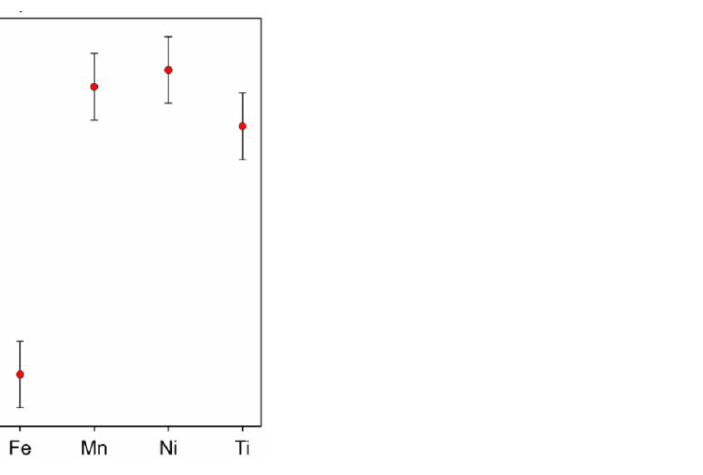
Figure 2. Tensile strengths of thin yellow cedar wood veneers treated with different metal acetylacetonates (six veneers per treatment) and exposed to natural weathering for 20 days in Australia.